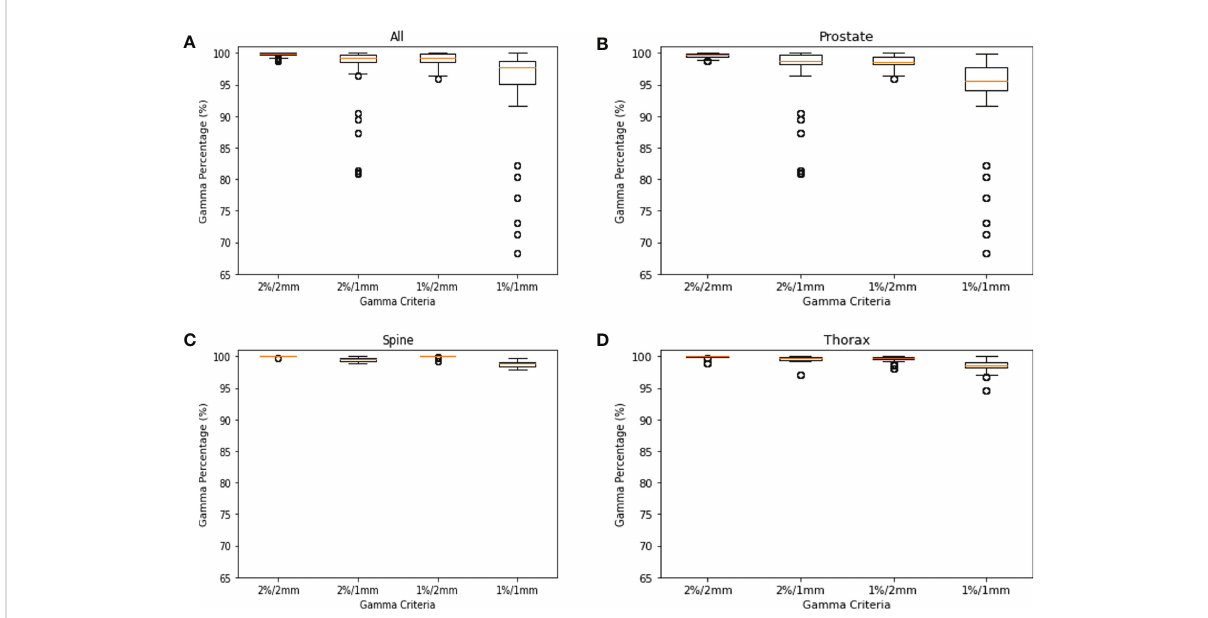
FIGURE 2 GPR Plots for Log File. (A) GPR of all log fi les for 2%/2mm, 2%/1mm, 1%/2mm & 1%/1mm. (B) GPR of prostate log fi les for 2%/2mm, 2%/1mm, 1%/2mm & 1%/1mm. (C) GPR of spine log fi les for 2%/2mm, 2%/1mm, 1%/2mm & 1%/1mm. (D) GPR of thorax log fi les for 2%/2mm, 2%/1mm, 1%/2mm & 1%/1mm.